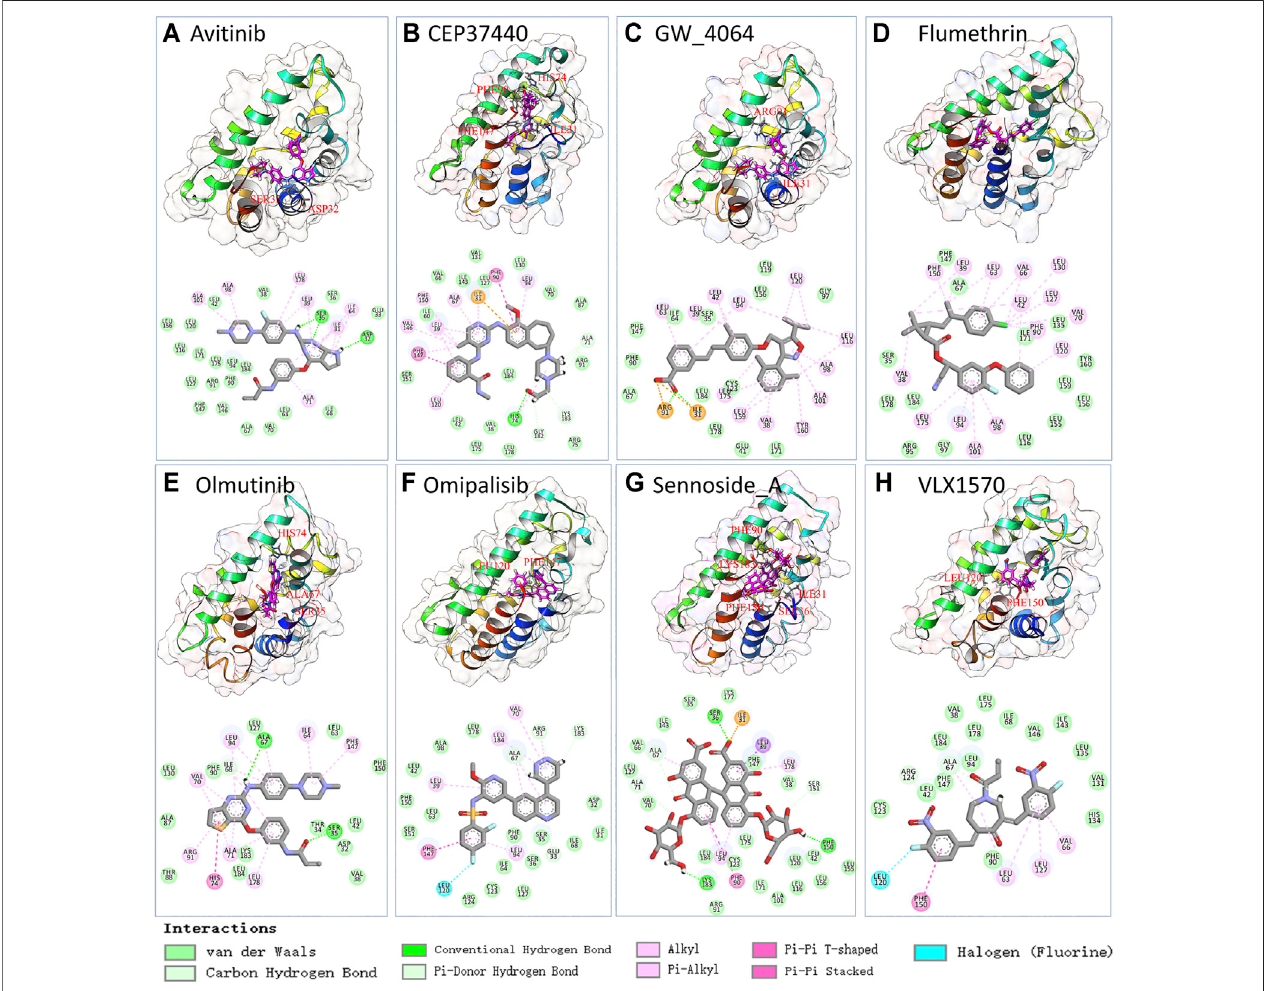
FIGURE 3 | The snapshot and 2D interaction of last frame conformation from the 100 ns MD simulations trajectories of candidate list 1.